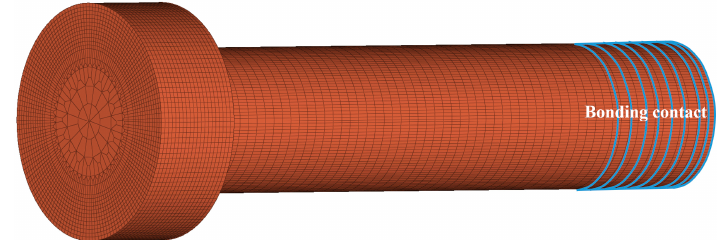
Figure 7. Simplified bolt model.